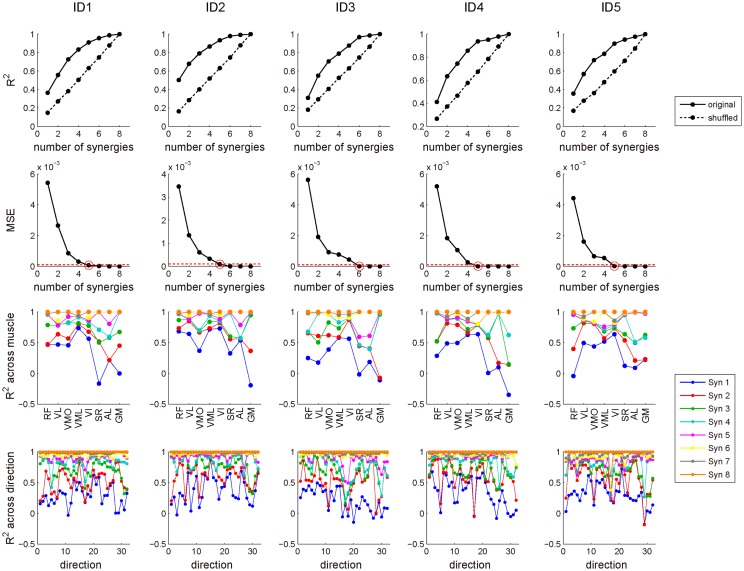
R2 value for determining the number of muscle synergies. Top: the amount of total variability explained (R2) as a function of the number of synergies obtained from original (solid line) and shuffled (dotted line) EMG datasets across each subject. Second: mean square residual error (MSE) of the regression line on R2 curve from that number of muscle synergy to the maximum was computed. We selected the least number of muscle synergies (red circle), which MSE was <10−4 (red dash line). Third: R2 value across each muscle. Each line represents the R2 value of the certain number of muscle synergies. Bottom: R2 value across each of 32 target directions. Each line represents the R2 value of the certain number of muscle synergies. Syn, synergy.